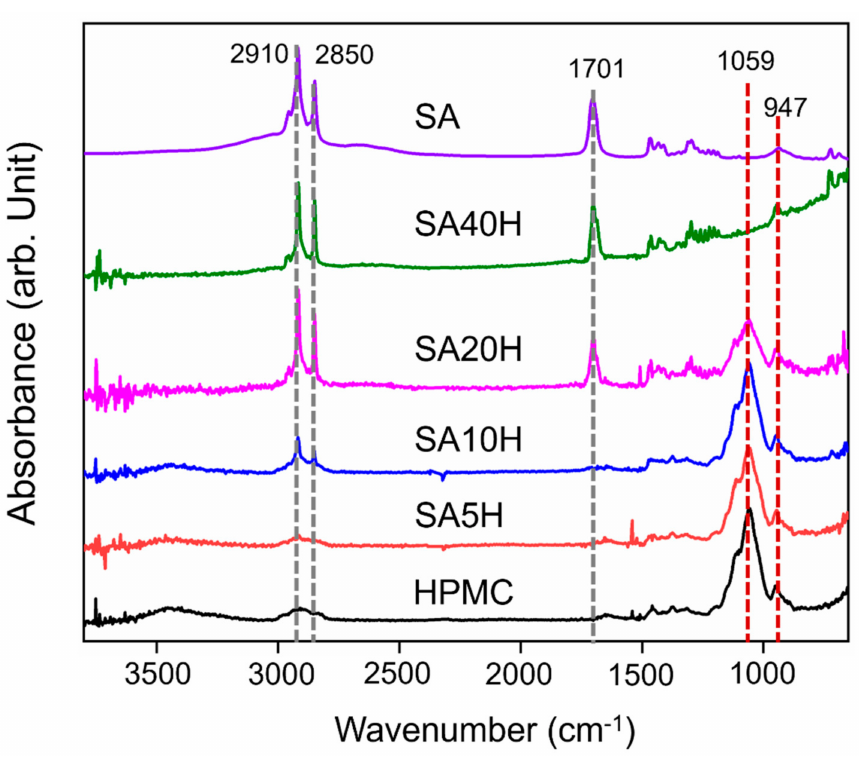
Figure 2. ATR-FTIR spectrum analysis of composite films.